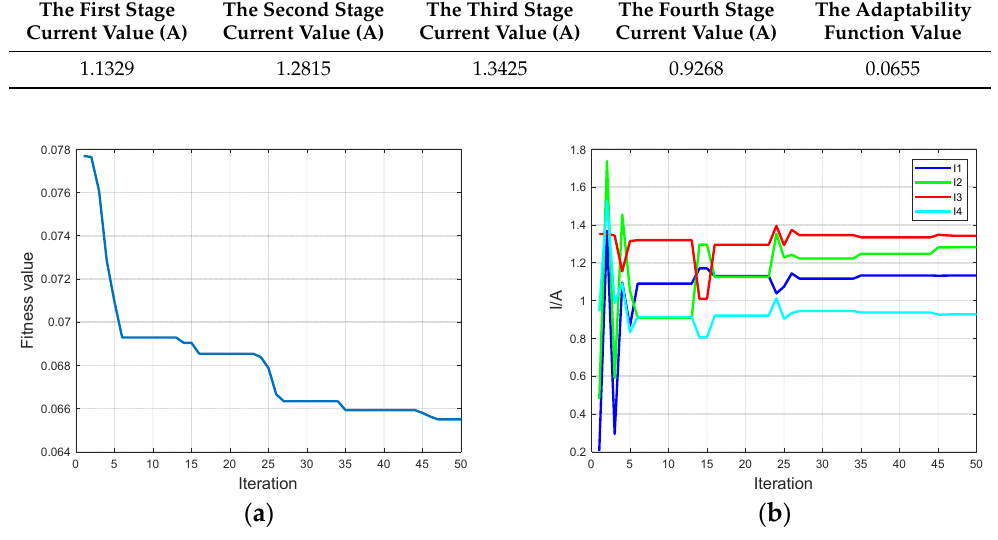
Figure 8. Four-stage constant current charging strategy optimization curve: ( a )fitness value curve; ( b )phase current value curve.